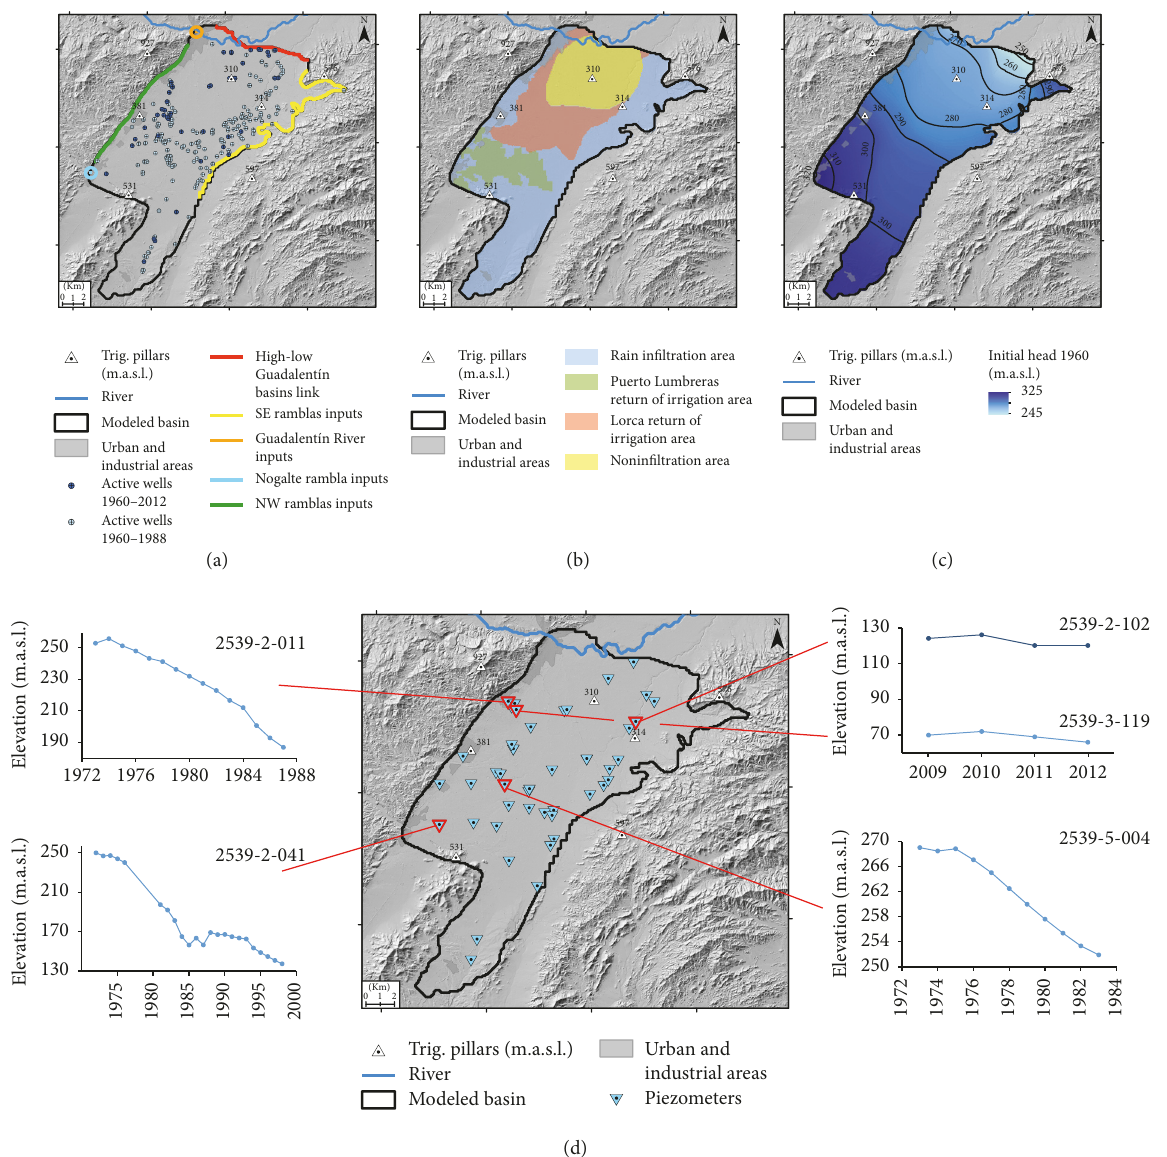
Figure 4: (a) Location of the lineal and punctual boundary conditions. Circles represent pumping wells while contribution from ramblas is indicated by lines. (b) Surface infiltration boundaries. (c) Groundwater initial condition in 1960. (d) Observation network. Lateral graphics depict water table evolution in different basin areas during the period studied. Each graphic is associated with its well number in the upper- right